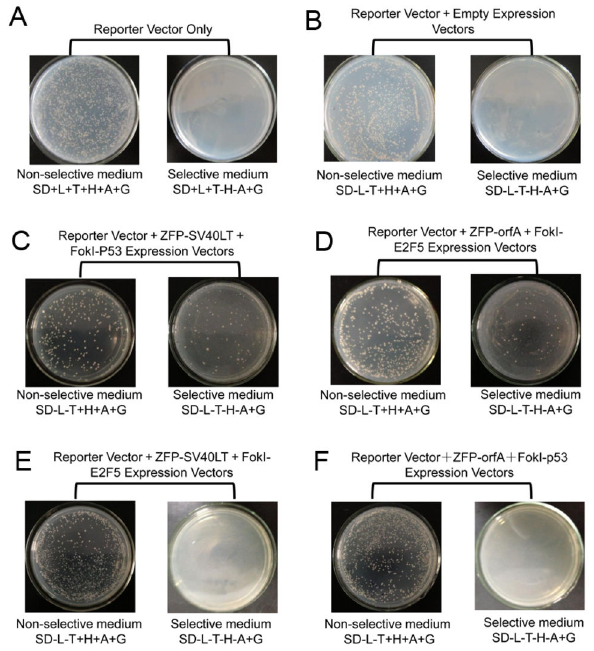
Figure 3. Confirmation of the ZFN-mediated protein identification system. Upon the interaction of well-known successfully cleaved DNA at target sites.